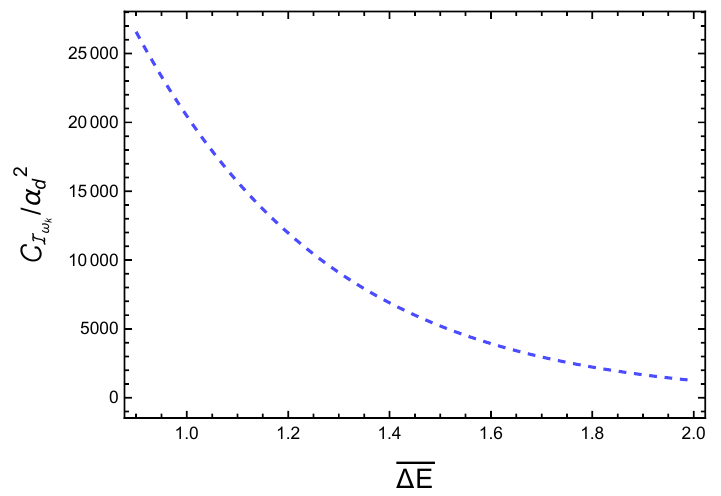
, signifying the concurrence, is plotted for two outgoing null /α 2 d ω k